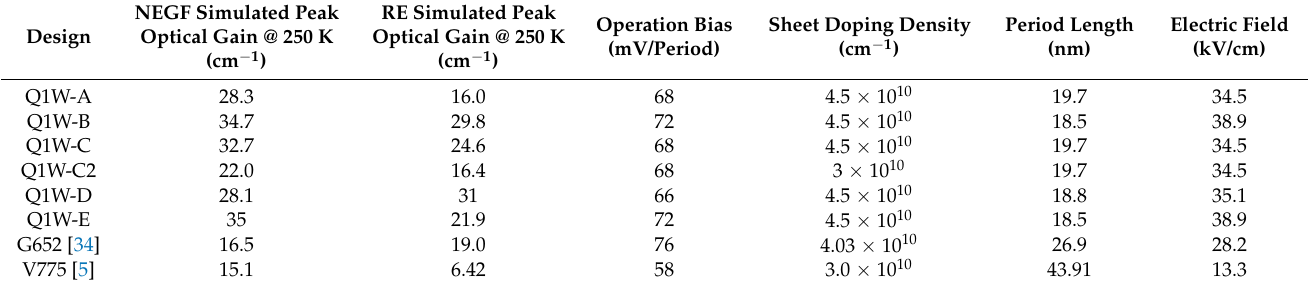
Table 1. Summary of optimized designs. Design A: 3.0 (27%Al)/8 (7%Al)/8.7 (GaAs). Design B: 3.0 (27%Al)/7.5 (7%Al)/8.0 (GaAs). Design C: 3.0 (25%Al)/8 (7%Al)/8.7 (GaAs). Design D: 3.0 (27%Al)/8.3 (5%Al)/7.5 (GaAs). Design E: 3.0 (30%Al)/7.5 (7%Al)/8.0 (GaAs). Layer thicknesses are shown in nm. The underlined layers are averagely doped. The operation bias and electric field are calculated by nextnano. NEGF